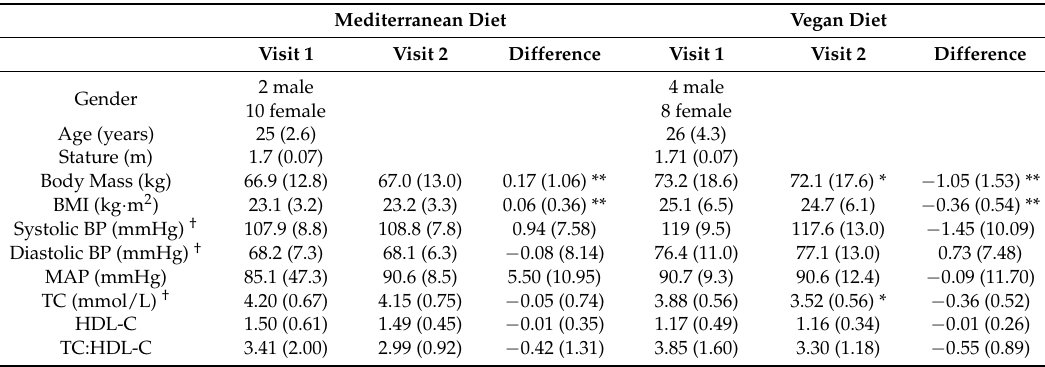
Table 2. Participants’